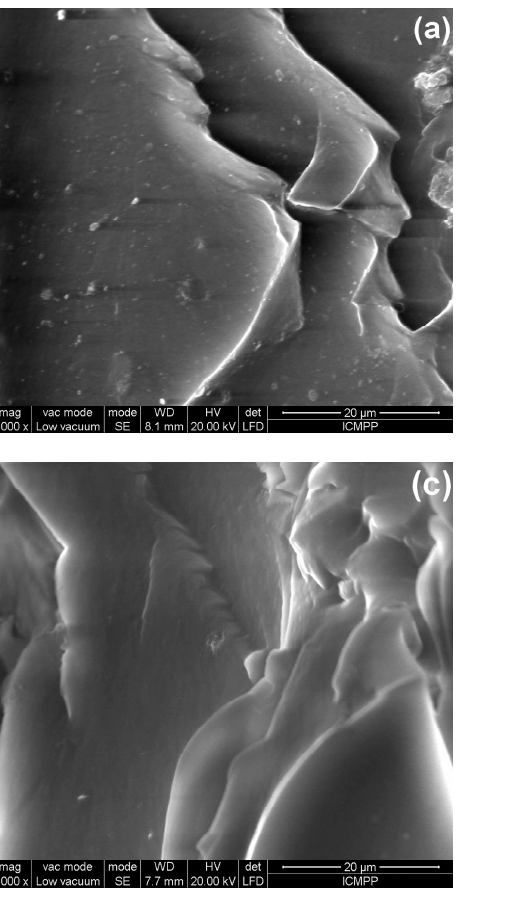
Figure 16. Micrographs of fractured surfaces of EPDM (M ( a ) and EPDM blends (E–B ( b ); E–Cl–B ( c ); E–Br–B ( d )) after irradiation at 20 kGy (5000× magnification).